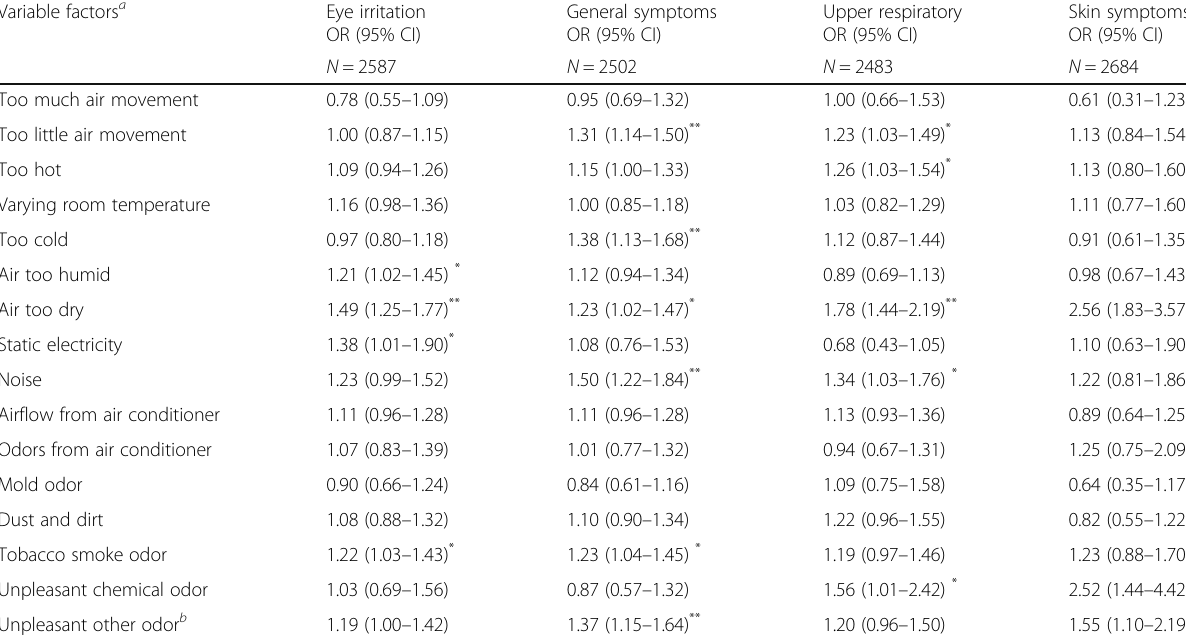
Table 5 Association between weekly building-related symptoms and workplace conditions in the last 4 weeks (Model 3) Variable factors